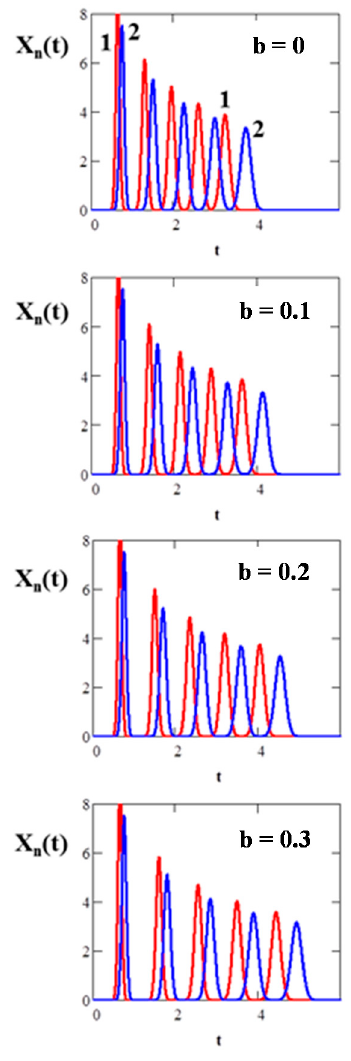
Figure 7. Simulation by Equation (5) of the closed-loop recycling countercurrent chromatography (CRL CCC) separations of the solutes K D1 = 0.3 and K D2 = 0.5 for different values of parameter b: N = 200, N ec = 200 , S = 0.5.